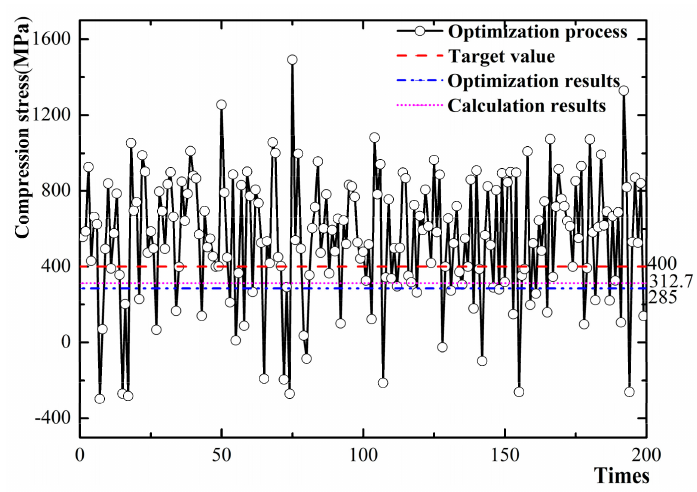
Figure 7. Compression stress optimization process, optimization results, and calculation results.